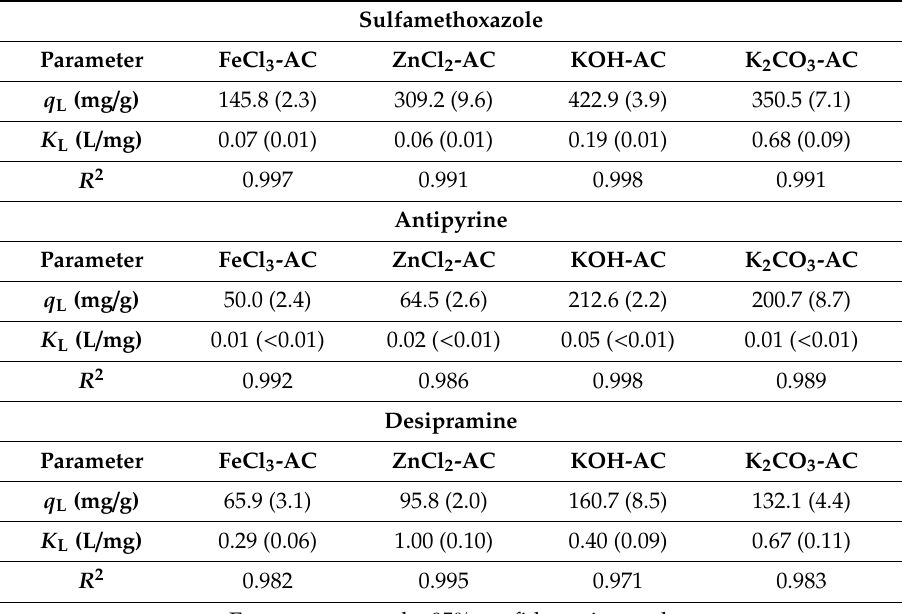
desipramine on chemically activated carbons obtained at 850 ◦